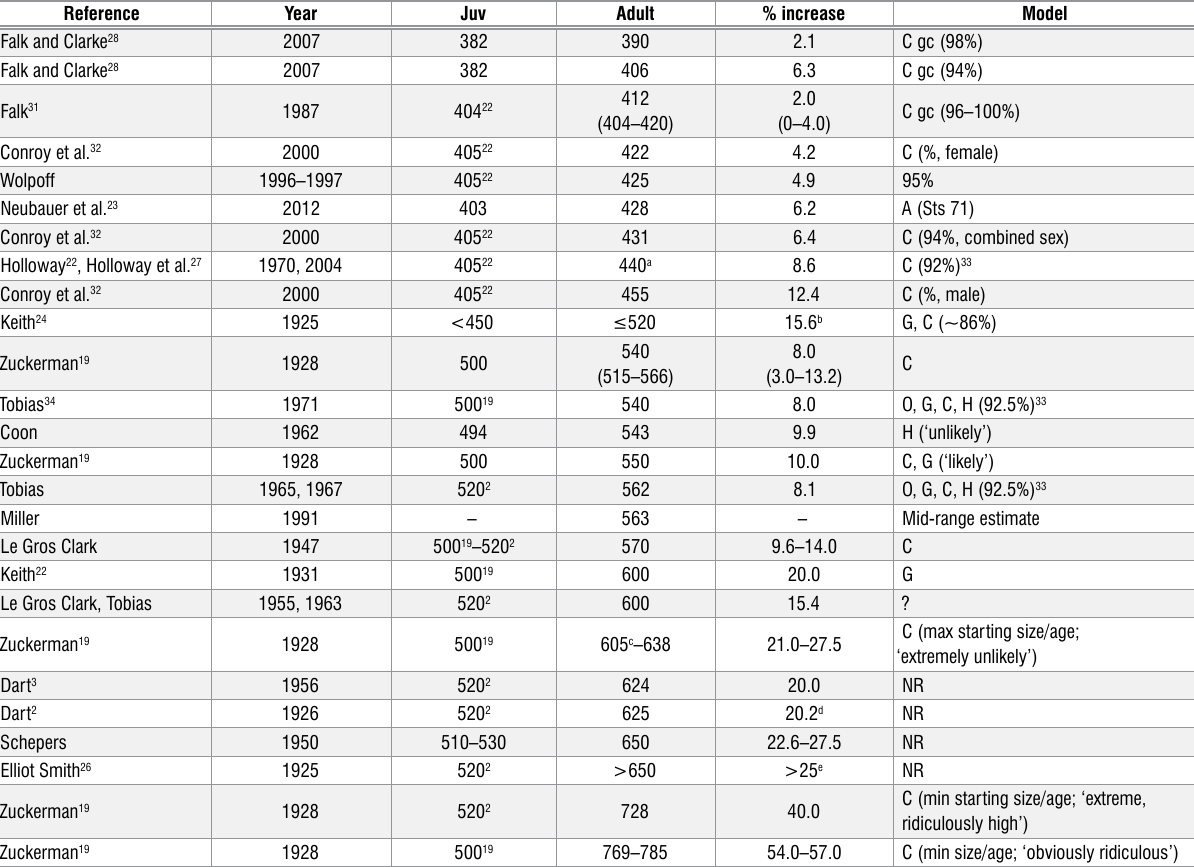
Previous juvenile and adult cranial capacity estimates for Taung presented in numerical order of adult cranial capacity. Table references are noted below or can be found in references 30,34 . C = chimpanzee; G = gorilla; H = modern human; A = australopith; gc = growth curve.